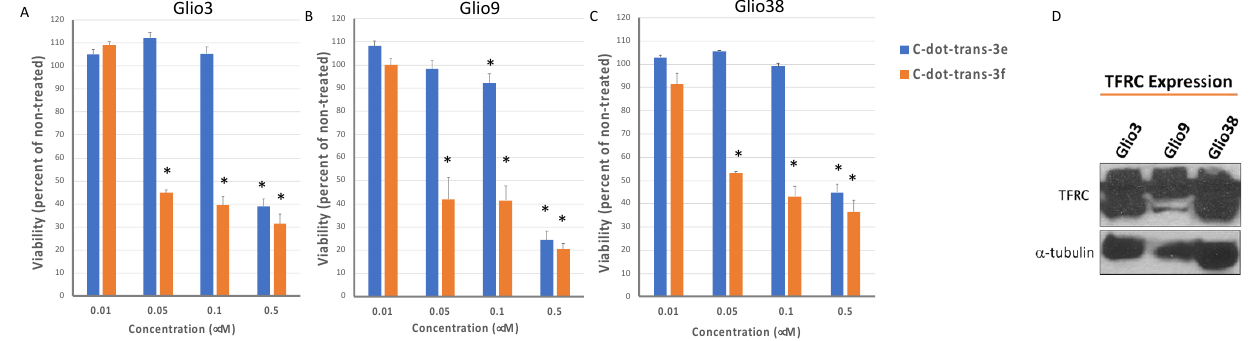
Figure 8. C-dot-trans conjugates induce cell death at nanomolar concentrations. GSC lines Glio3 ( A ), Glio9 ( B ) and Glio38 ( C ) were treated with C-dot-trans- 3e (orange) or C-dot-trans- 3f (blue) at concentrations shown and cell viability determined 72 h later. Data is presented as percent viability compared to non-treated controls. * p < 0.05 compared to non-treated controls. ( D ) Transferrin Receptor (TFRC) expression determined by Western blot analysis.